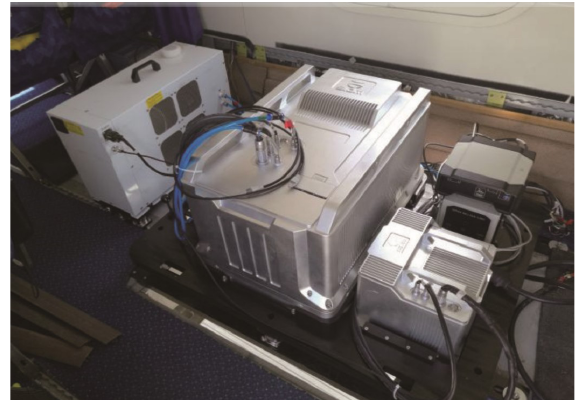
Figure 3. Mapper5000 System of Shanghai Institute of Optics and Machinery (He et